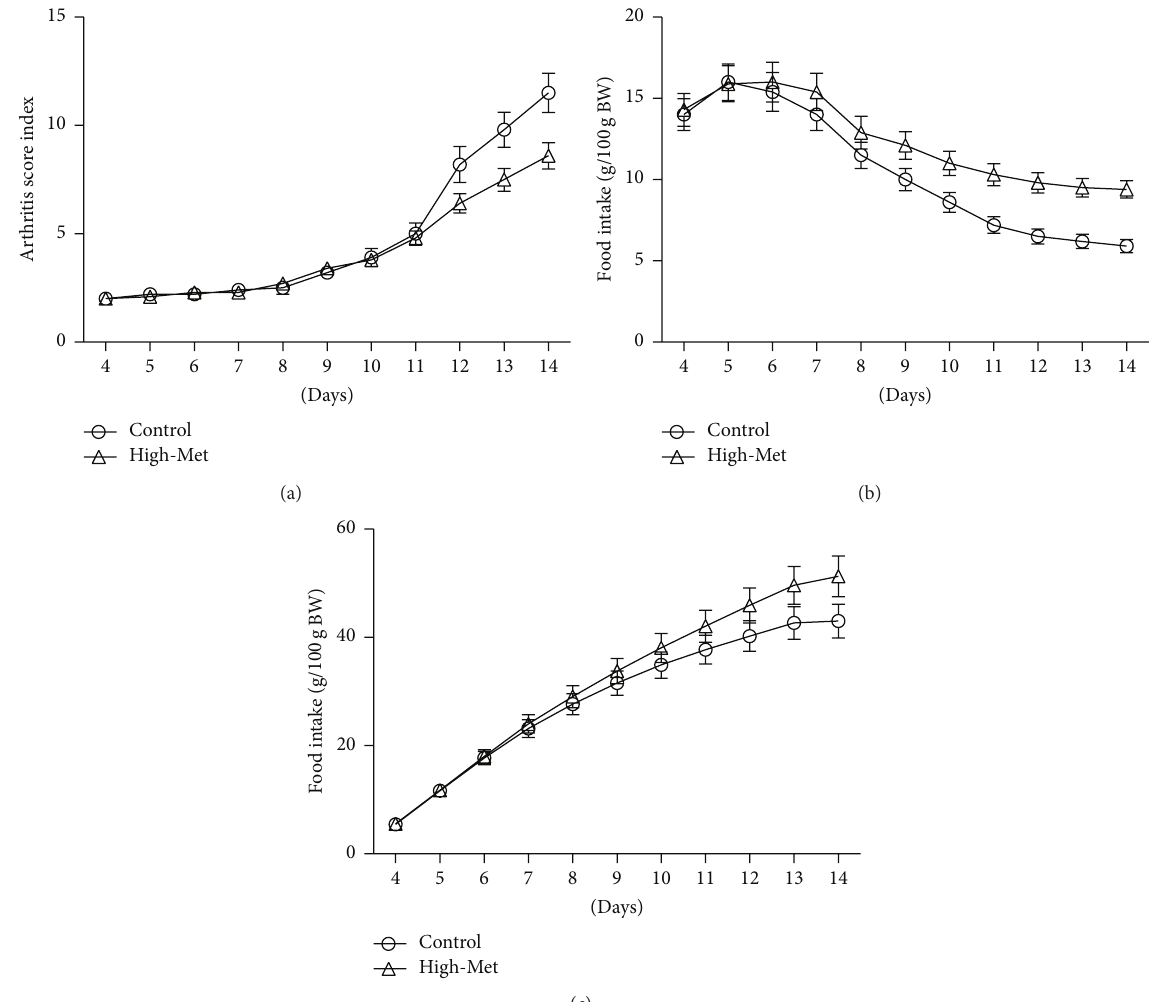
Figure 1: Arthritis index score (a) and consumption of food per 100 g/body weight (b), with the aggregate weight gain development (c) in days 4–14, following adjuvant injections within both the high-Met and control groups. Increased ASI corresponds to decreased food intake. Conversely, high-Met diets led to a rise in food consumption in comparison with the control group. Arthritic rats in the variable group collectively amassed a greater weight gain than the base group. Data are expressed as means ± SEM ( 𝑛 = 10 ).